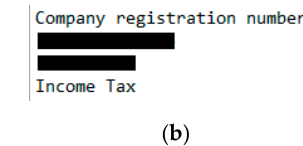
Figure 4. ( a ) An extract from the truth set and ( b ) an extract from corresponding OCR output. Note how the fields are read out of order in certain scenarios.